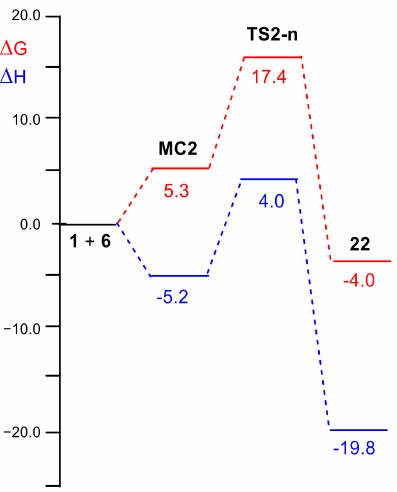
Figure 8. ω B97XD/6-311G(d,p) enthalpy, in blue, ∆ H in kcal mol –1 and Gibbs free energy, in red, ∆